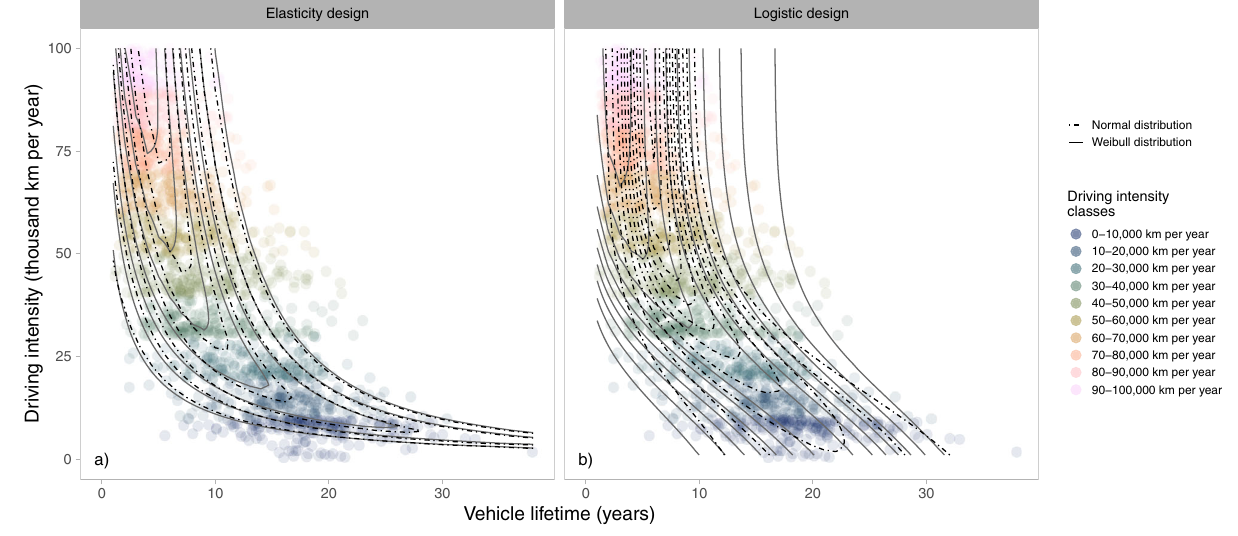
Fig. 4 | Semi-empiricalmodel results. a Results for the elasticity design. b Results for the logistic design. The contours show probability density levels and are pro- vided for both Normal (dot-dashed) and Weibull distributions (solid). Strati fi ed